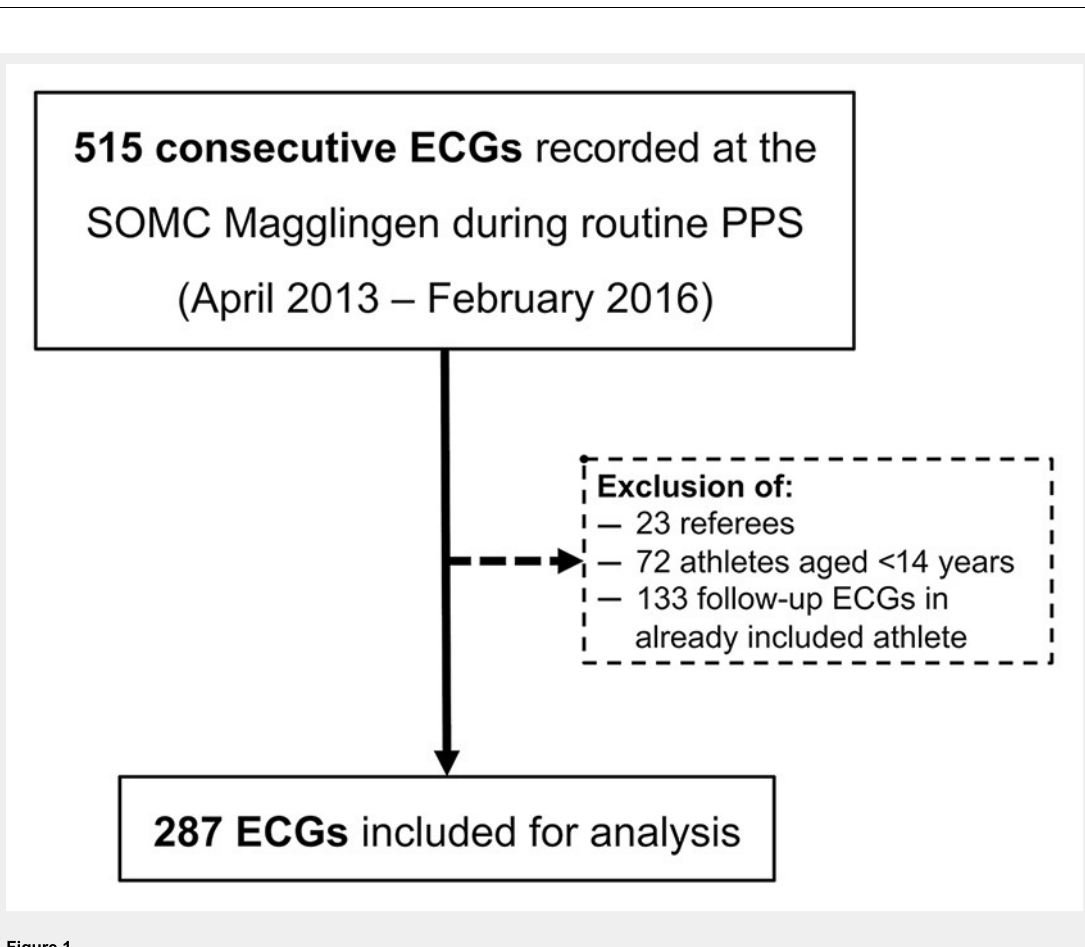
Figure 1 Flow-chart for ECG inclusion during the study period. PPS = pre-participation screening; SOMC = Swiss Olympic Medical